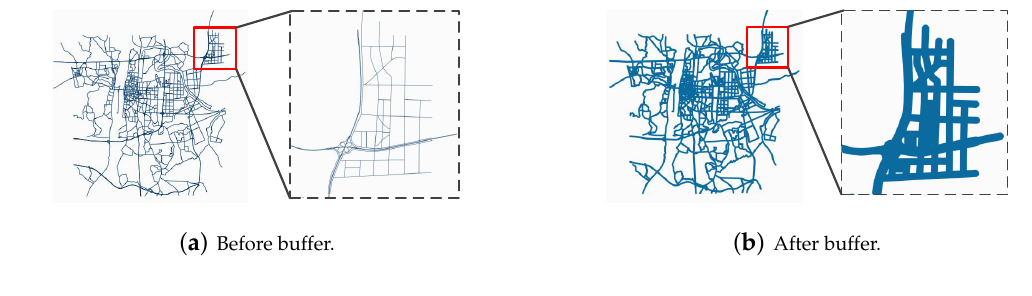
Figure 2. Changsha city road buffer